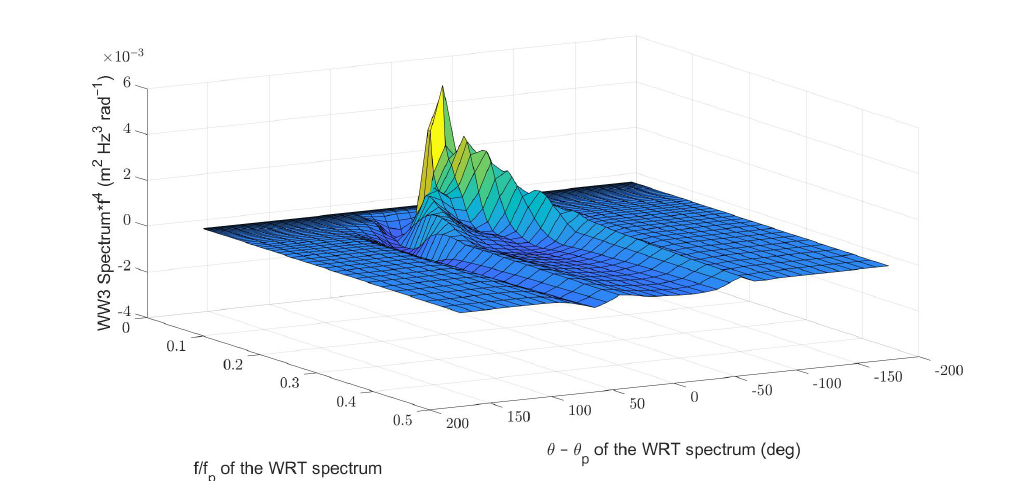
Figure 3. Difference between the WW3/DIA-40 and WW3/WRT-40 spectra shown in Figures 1 and 2, respectively, for the Draupner